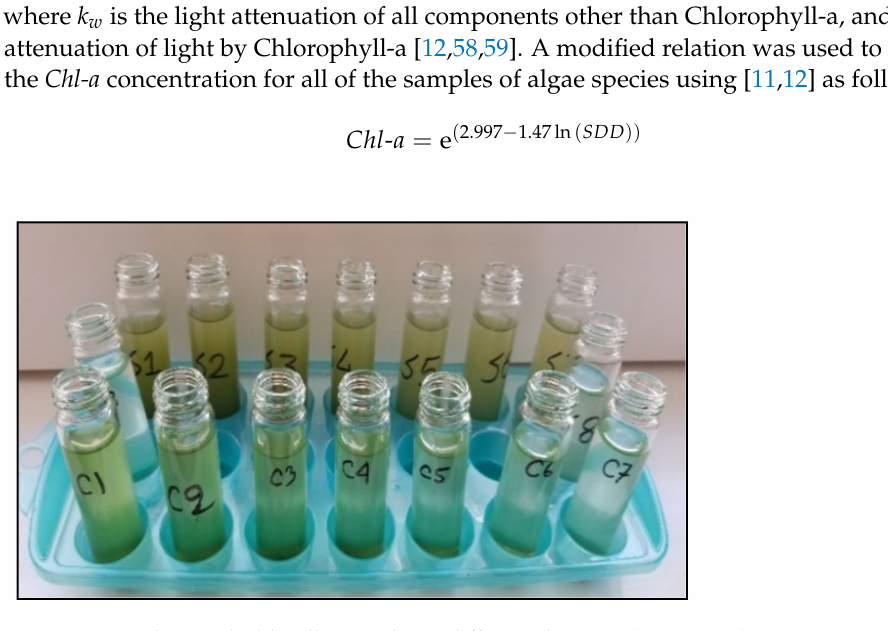
Figure 1. Spirulina and Chlorella samples at different densities (6.25–100%). The SDD index for different concentrations of algae samples was recorded from